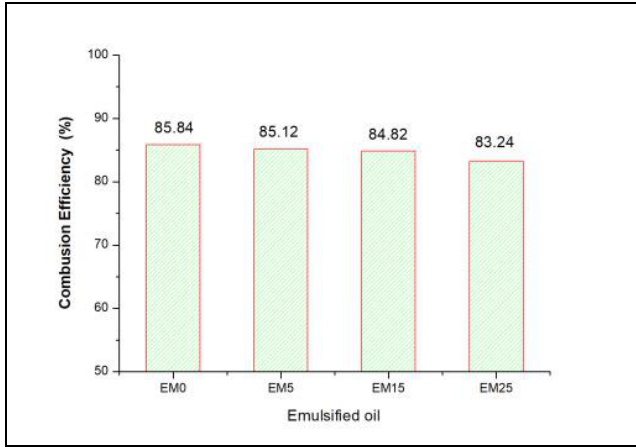
Figure 11. Combustion efficiency comparison of emulsified oils.